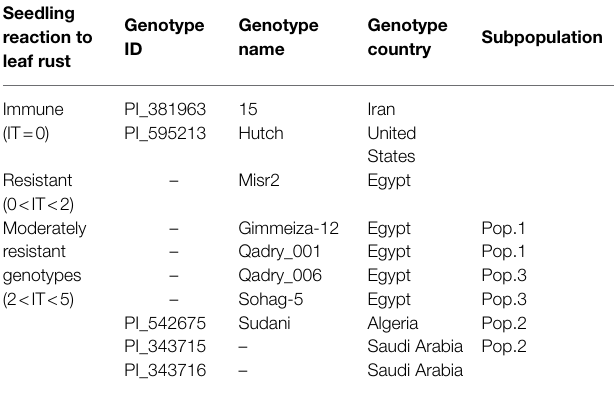
seven genotypes were found to be MR to all studied races ( Supplementary Figure S2 ). These MR genotypes were from three different countries as follows: Egypt (four genotypes), Saudi Arabia (two genotypes), and Algeria (one genotype).